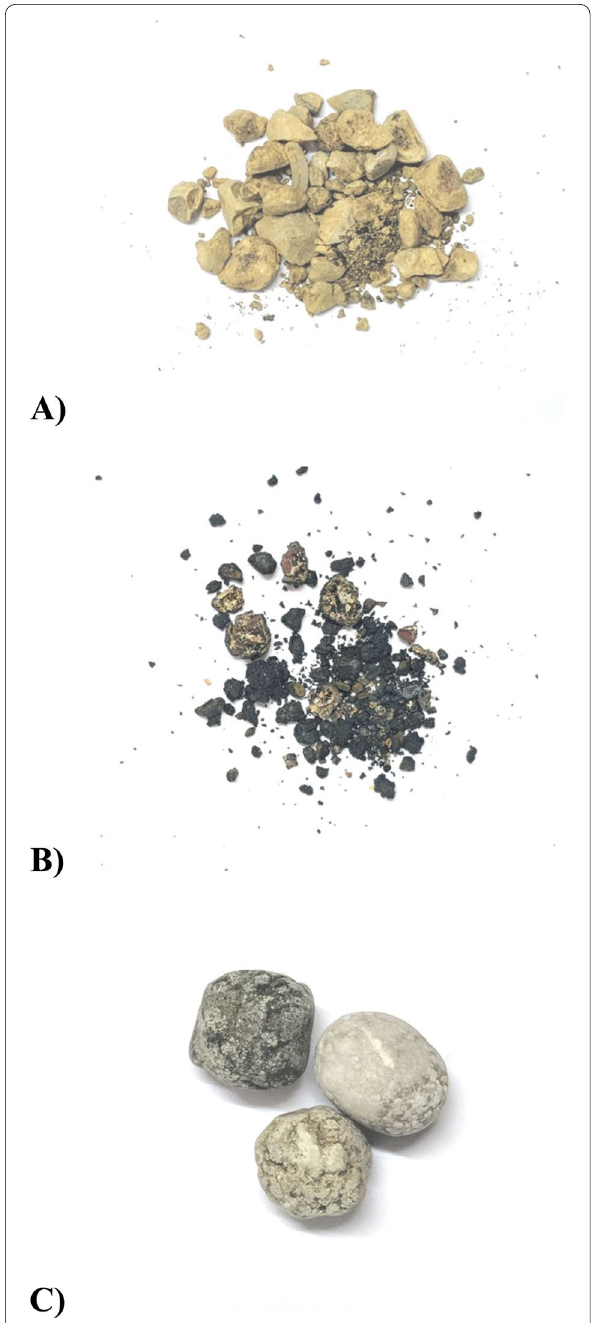
Fig. 2 Various types of gallstones. A Cholesterol. B Pigment. C Mixed